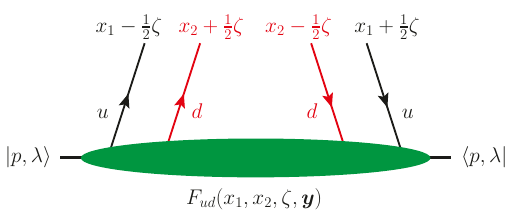
Figure 1 . Illustration of a skewed DPD of a u and a d quark for the case where all fractions x i ± ζ/ 2 are